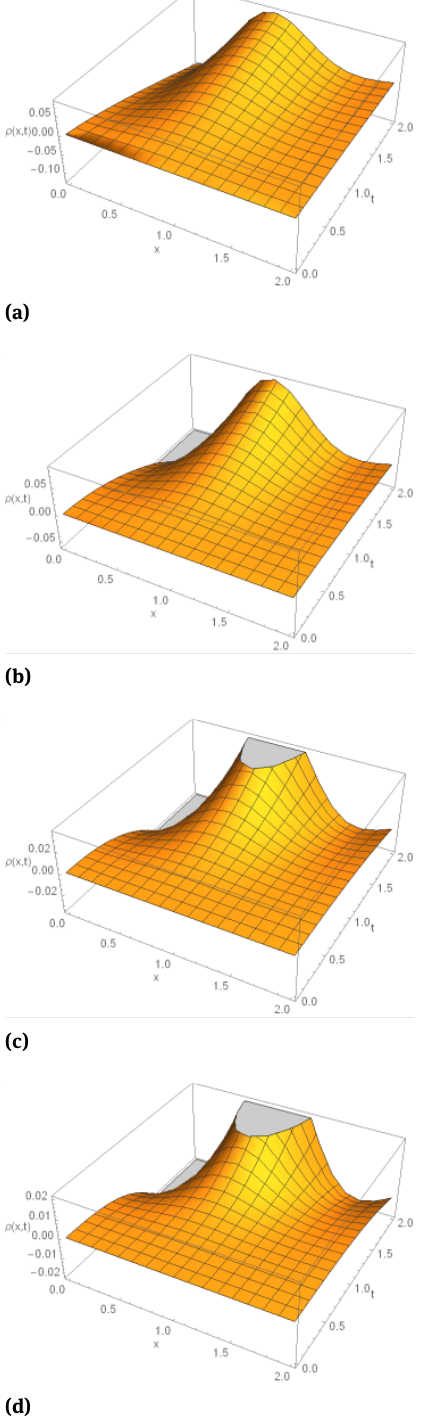
Figure 3: The surface graph of approximate solution v ( x , t ) for case- II: (a) v ( x , t ) for β = 1 (b) v ( x , t ) for β = 0.8 (c) v ( x , t ) for β = 0.6 (d) v ( x , t ) for β =